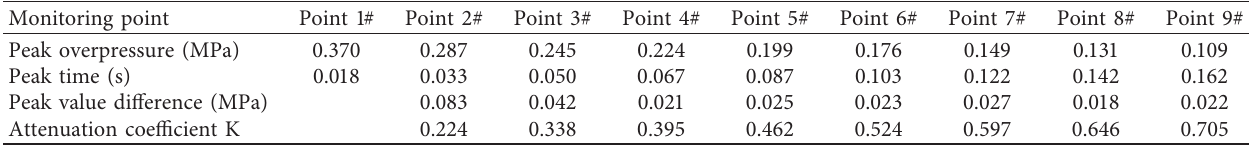
Table 1: Parameters of each monitoring point.